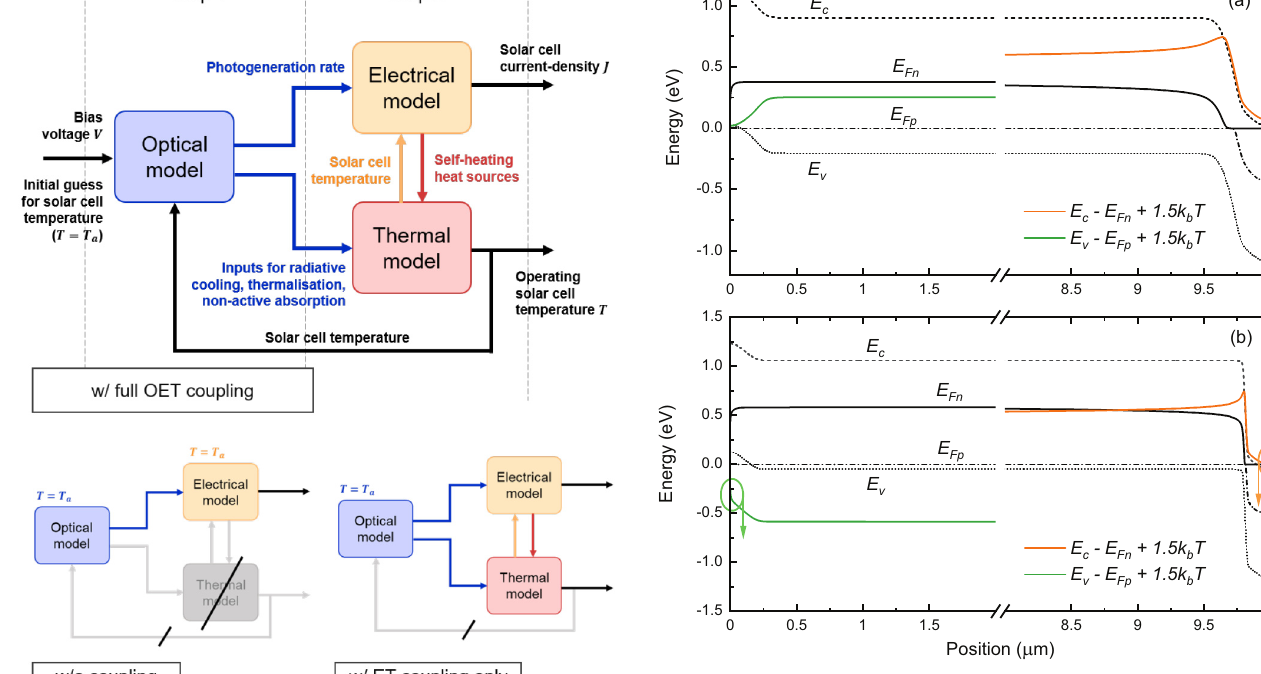
Fig. C.1. Band diagram of the reference solar cell (a) and the heavily doped cell (b), at short-circuit condition in a fully coupled scenario. The front side emitter is located at 10 m m while the rear side BSF is located at 0 m m. The values of E c (cid:1) E Fn +1.5 k b T and E v (cid:1) E Fp +1.5 k b T involved in the Peltier effect are shown in orange and green,